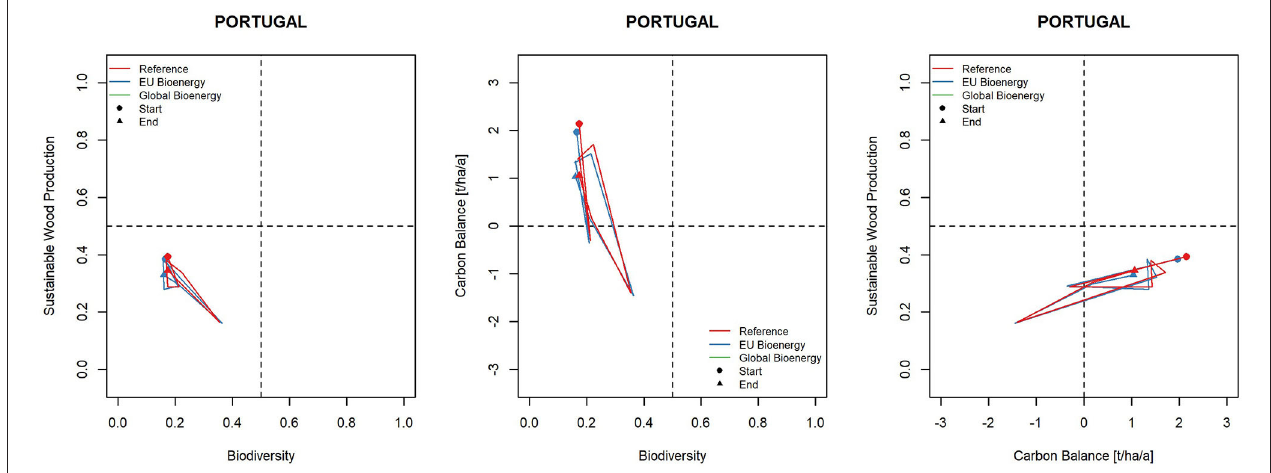
FIGURE 9 | Trade-off diagrams for